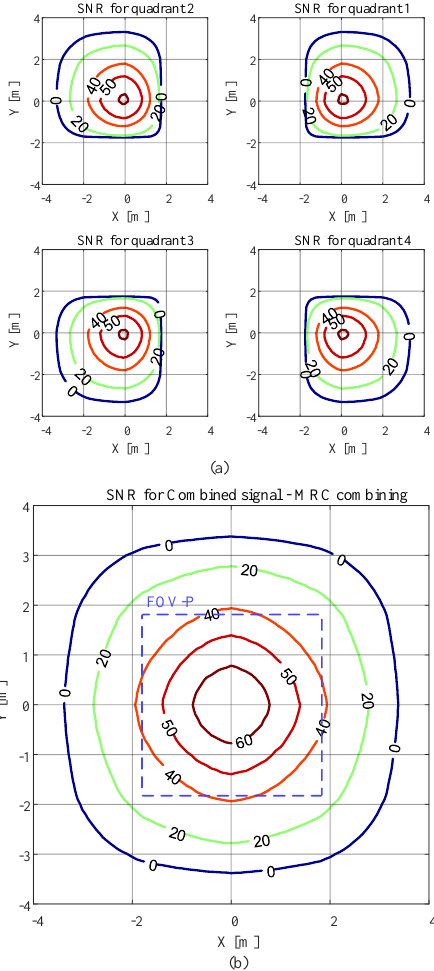
Figure 8. SNR in dB versus QADA location in an area equipped with a single transmitter with m = 4 and with the receiver parallel to the plane on which the luminaire is located with a FOV-C of 63.4 ◦ for ( a ) each quadrant; ( b ) the combined signal using